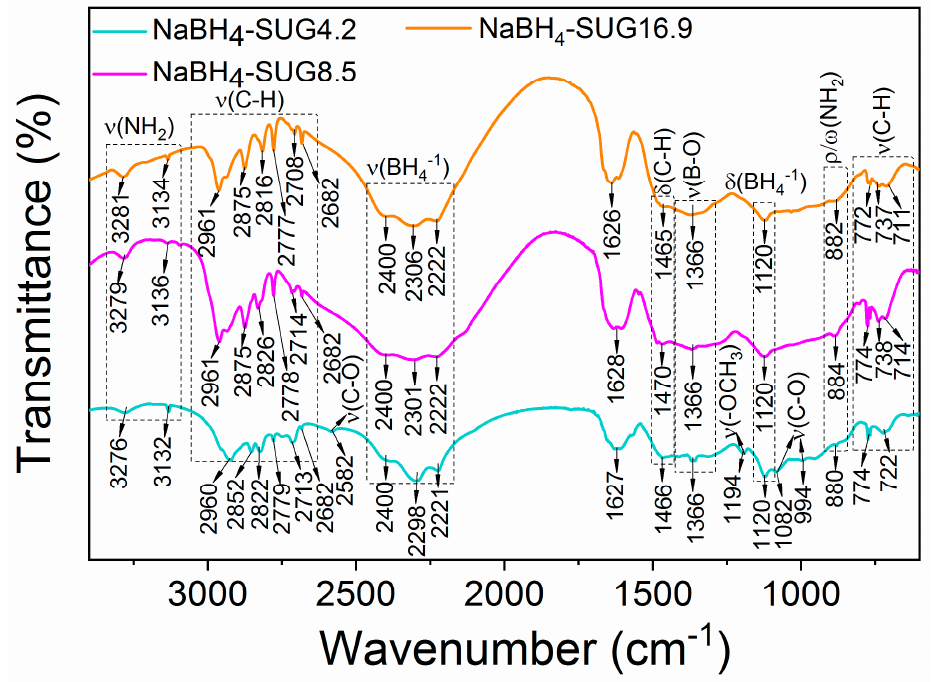
Figure 6. FTIR spectra of the as-synthesized NaBH 4 via suspension-gas interaction.